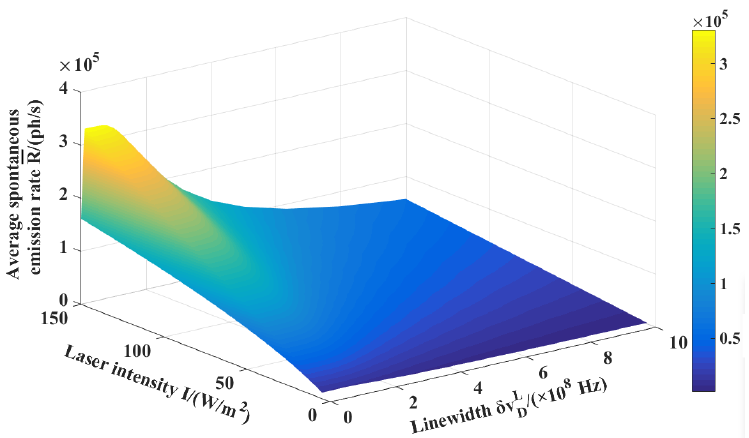
Figure 6. Average spontaneous emission rates vs. linewidth and intensity from 5 to 150 W/m 2